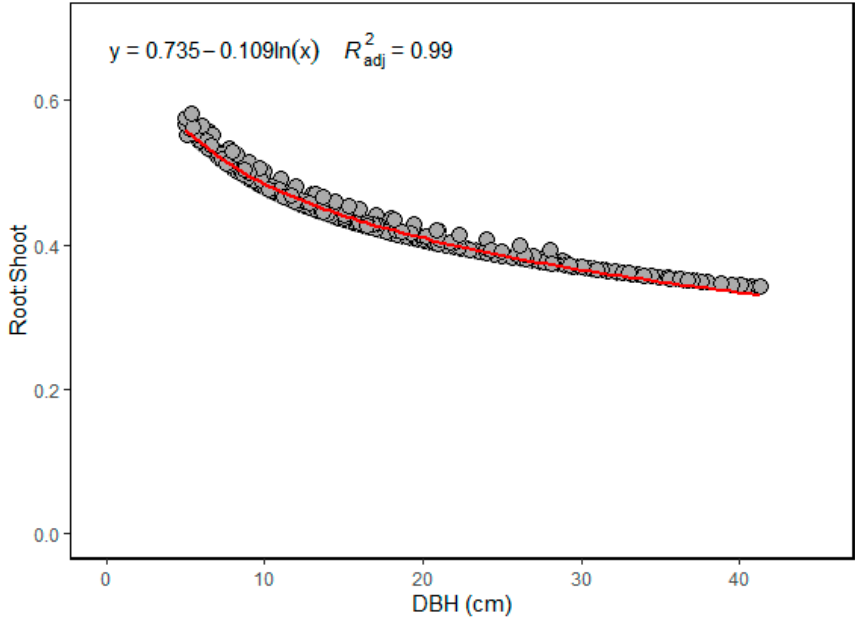
Figure 5. Root: Shoot (R:S) ratios against tree diameter at breast height (DBH in cm). The biomass of the plant is associated with the carbon-storing capacity of the plant [55], so estimating the biomass potential of mangrove vegetation can be used to calculate the carbon stock. The total carbon stock (C-stock) of the mangrove stand in LetKhutKon Village was 3754.304 Mg C ha − 1 and varied from 17.37 Mg C ha − 1 to as high as 373.06 Mg C ha − 1 with a mean value of 150.25 ± 81.35 Mg C ha − 1 . The average C-stock of the mangrove